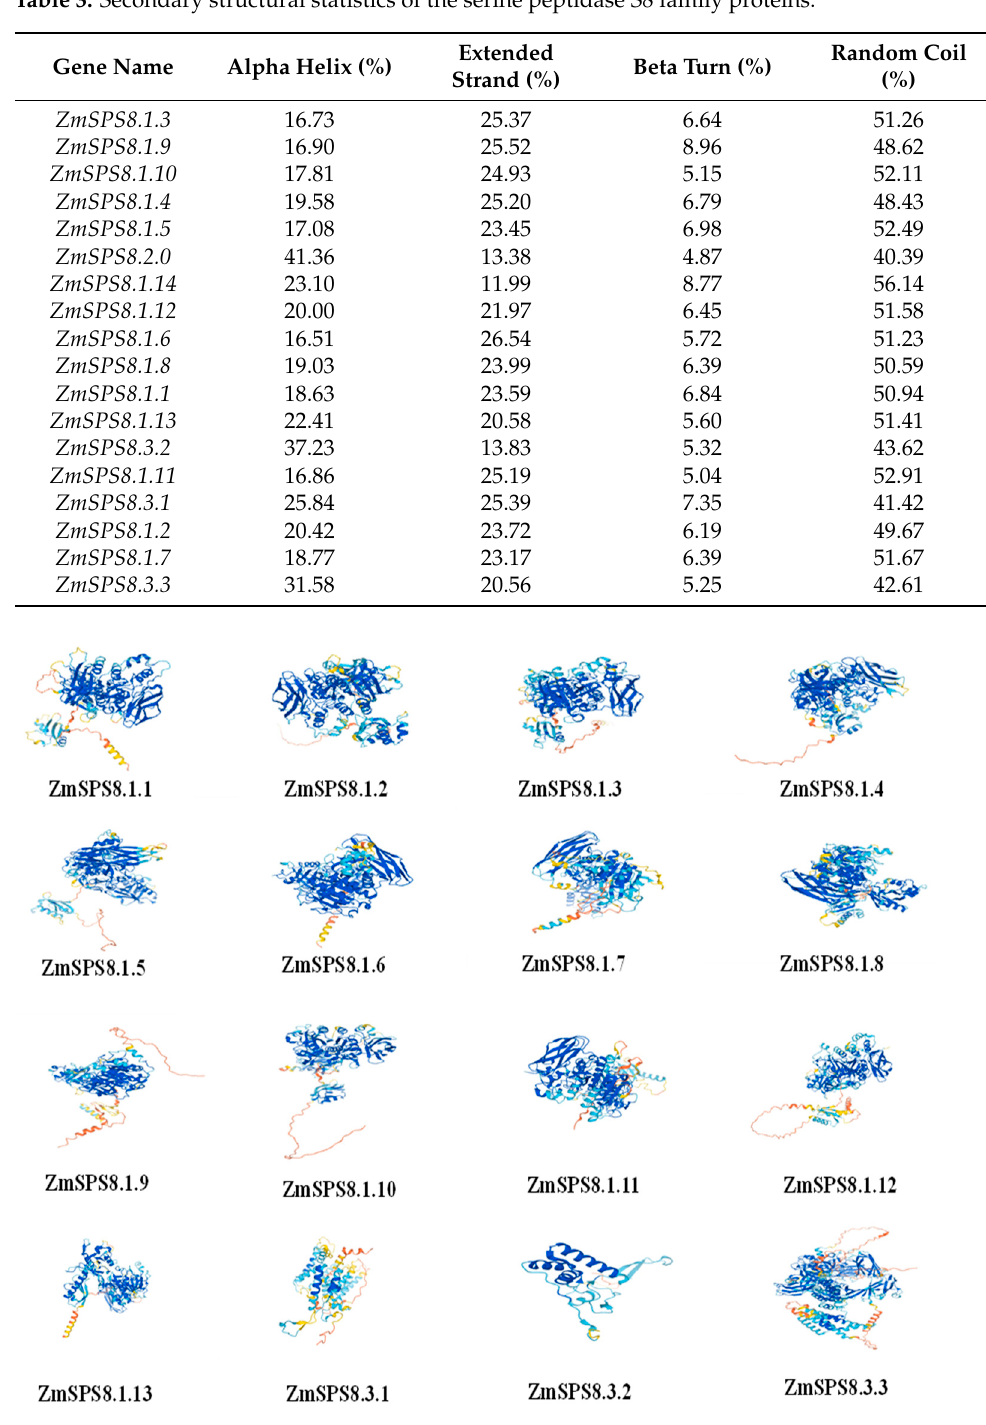
Figure 3. Three-dimensional Models of the serine peptidase S8 family